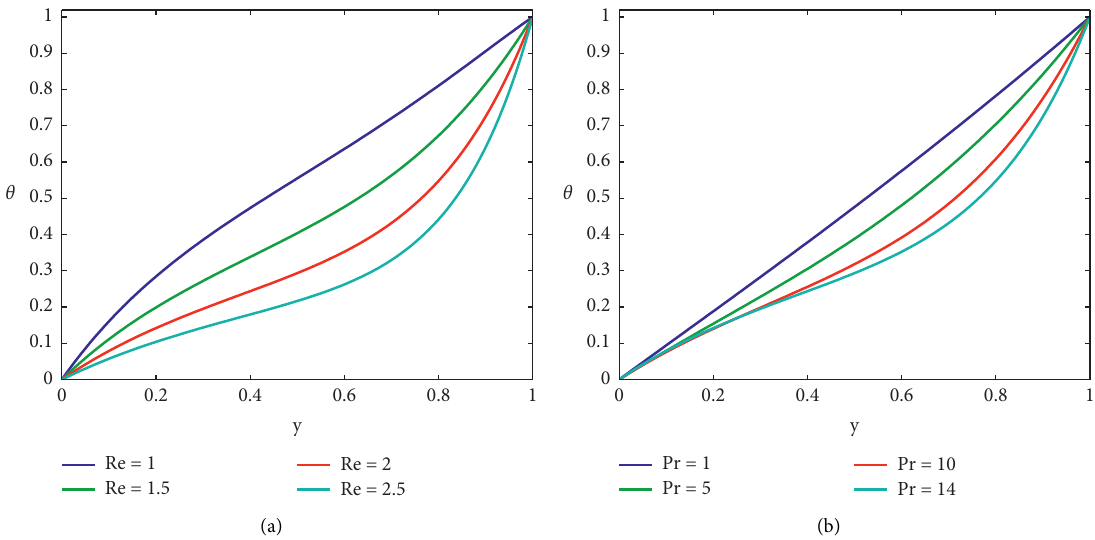
Figure 6: (a) Effect of Re on the “temperature distribution” when Pr � 14. (b) Effect of Pr on the temperature distribution when Re �